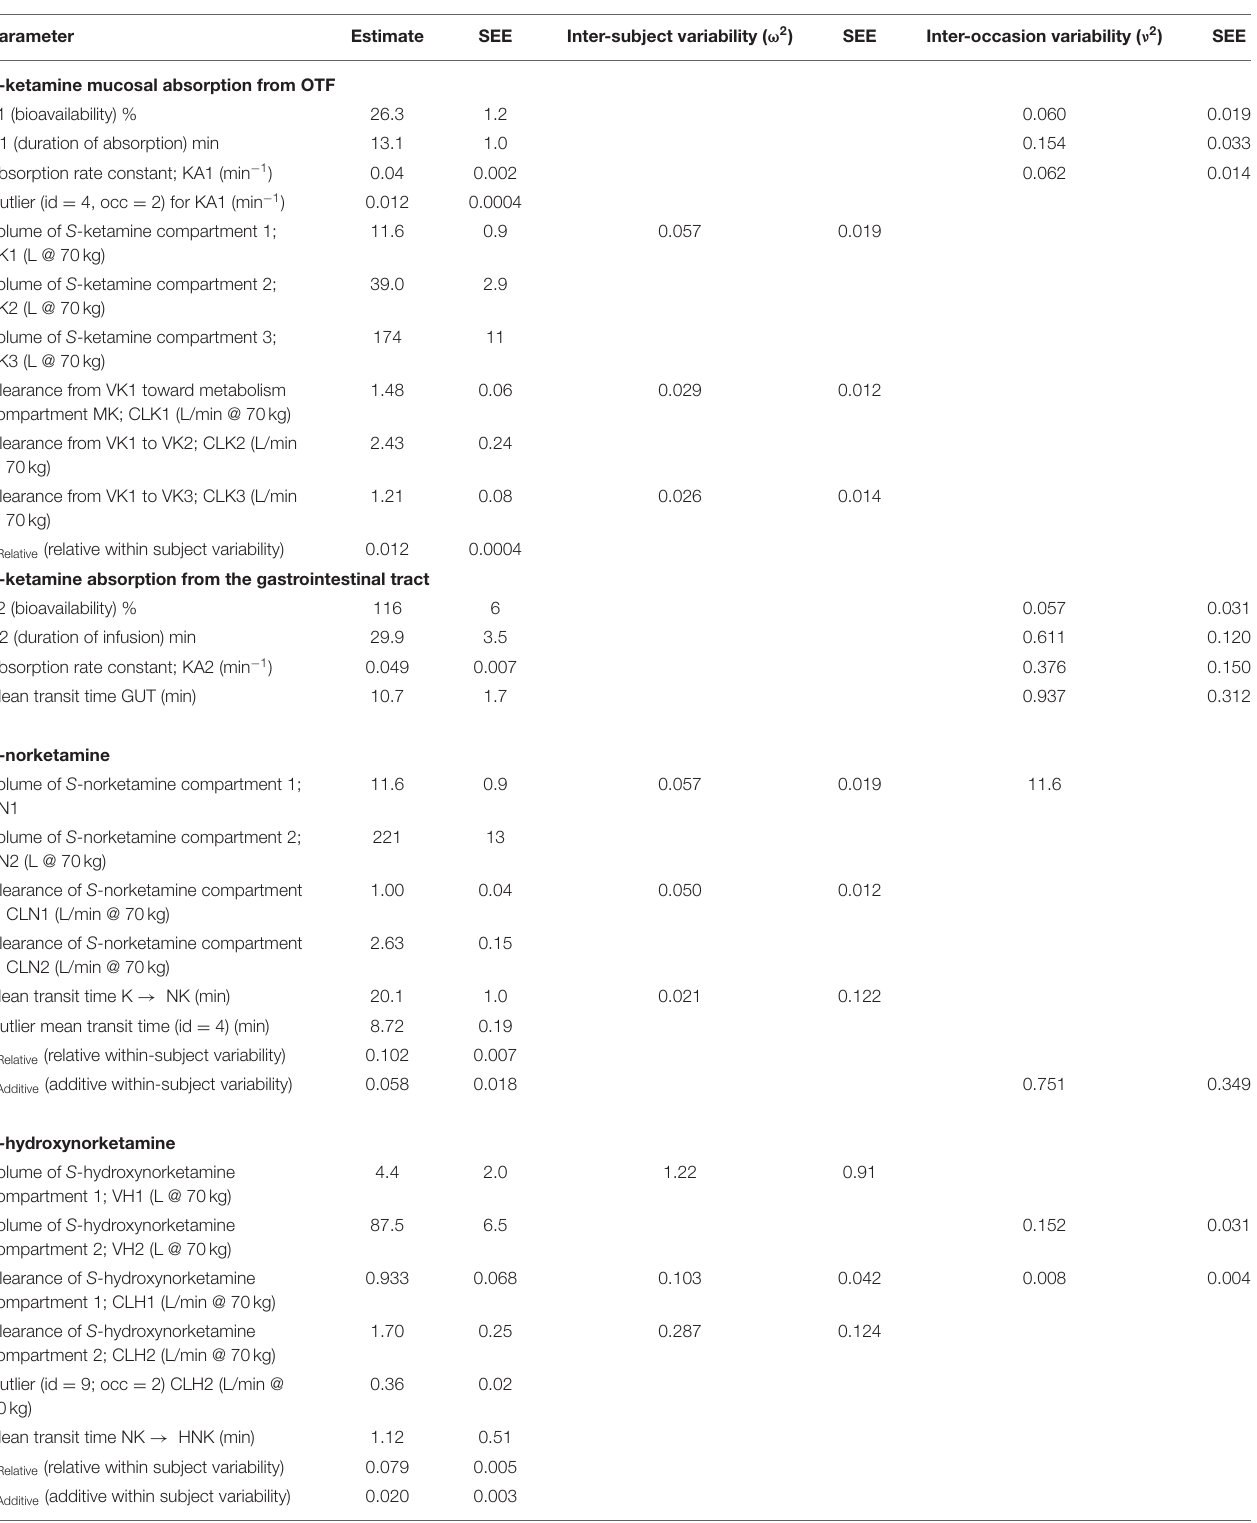
TABLE 4 | S- ketamine OTF pharmacokinetics. Parameter Estimate SEE Inter-subject variability ( ω 2 ) SEE Inter-occasion variability ( ν 2 )